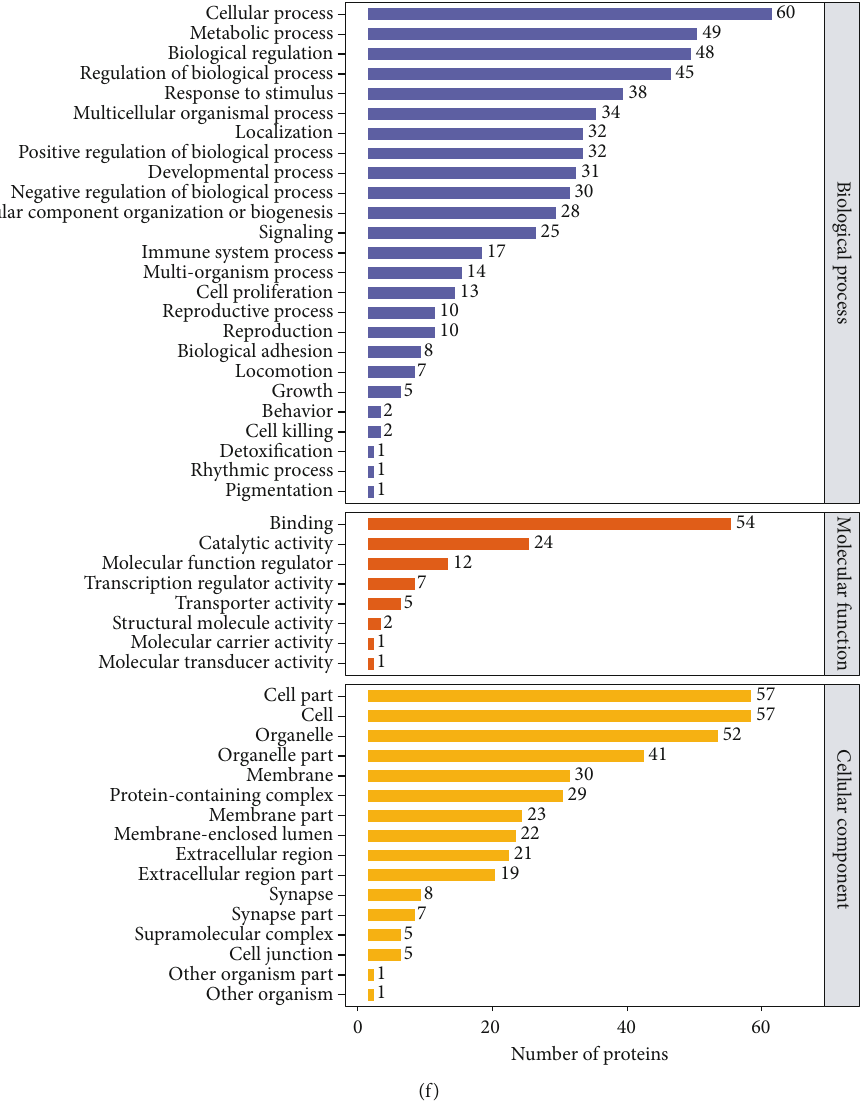
Figure 1: A disintegrin and metalloprotease 10 (ADAM-10) depletion induces matrix metalloproteinase 12 (MMP-12) disorders in RAW264.7 cells. (a) ADAM-10 interference in RAW264.7 cells. Scale bar = 100 μ m . The dot plots show the statistical analysis of the expression level of ADAM-10 via qualitative PCR (qPCR). Each dot represents a readout. (b) Tandem mass tag (TMT) results; 40 proteins were downregulated and 30 proteins upregulated in ADAM-10 RAW264.7 depleted cells compared to control cells. Each dot represents a readout. (c) Hierarchical clustering analysis results of the signi fi cant proteins from (b). Results are shown in a heat map. (d) KEGG pathway analysis of the di ff erent proteins. (e) Protein interaction network analysis revealing that interfered ADAM-10 (sh ADAM-10) decreases MMP-12 expression. (f) Biological Process Gene Ontology (GO) term enrichment analysis results for the di ff erent